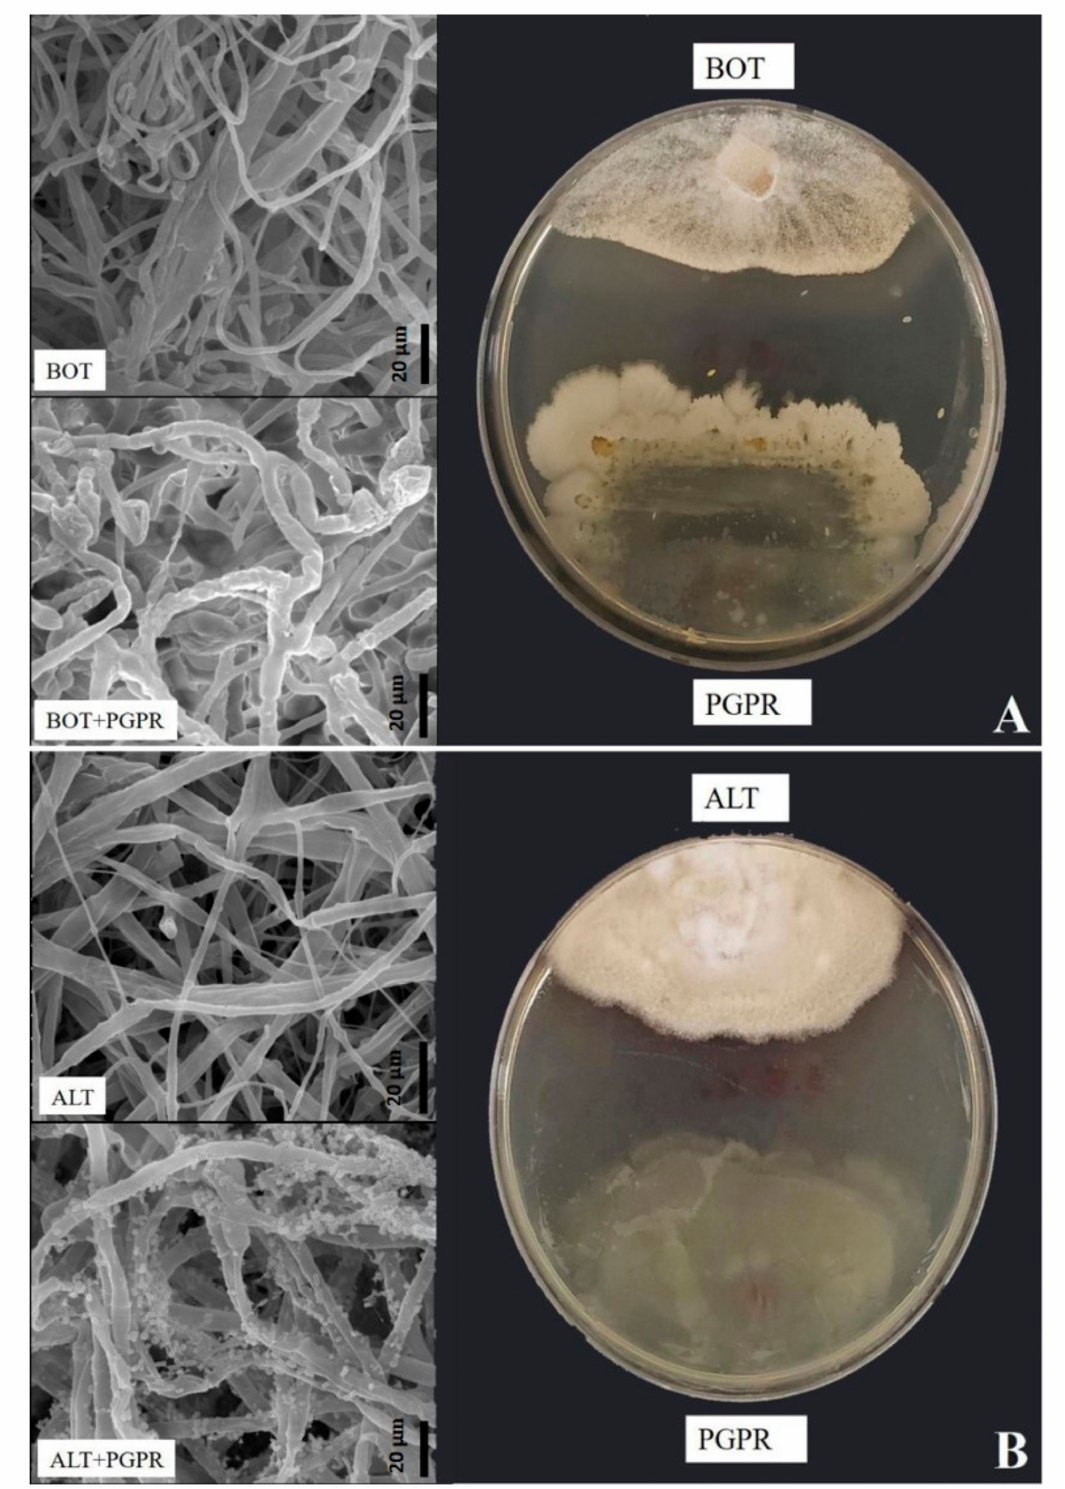
Figure 3. Effect of Bacillus amyloliquefaciens on Botrytis pelargonii and Alternaria alternata hyphae morphology evidentiated using a scanning electron microscope. ( A , B ) Abnormal hyphae. Wrinkled, ruptured, or shrunken patterns under Bacillus amyloliquefaciens treatment. ( A , B ) Normal patterns of hypha in the